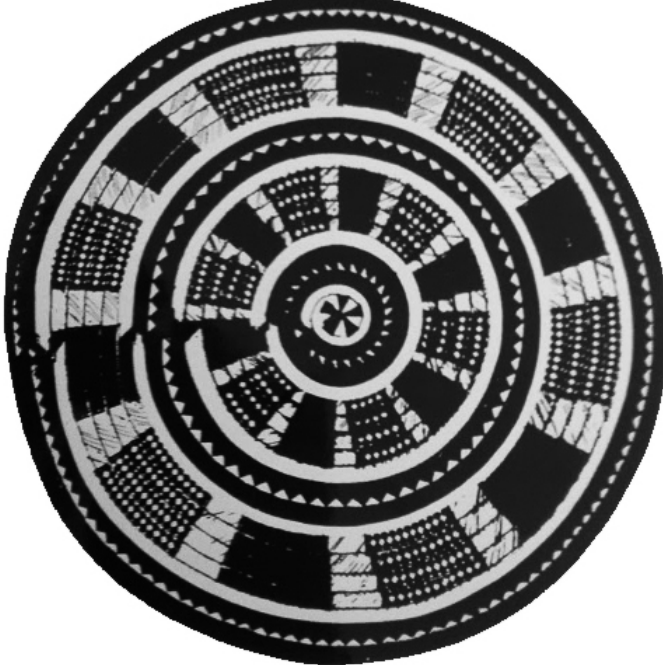
Figure 7. Vueltiao hat image, typical expression of Cordoba’s artisanal work. Source: Centro de Documentaci ó n Regional Orlando Fals Borda-Banco de la Rep ú blica Monter í a. Folder p. 23 [2].